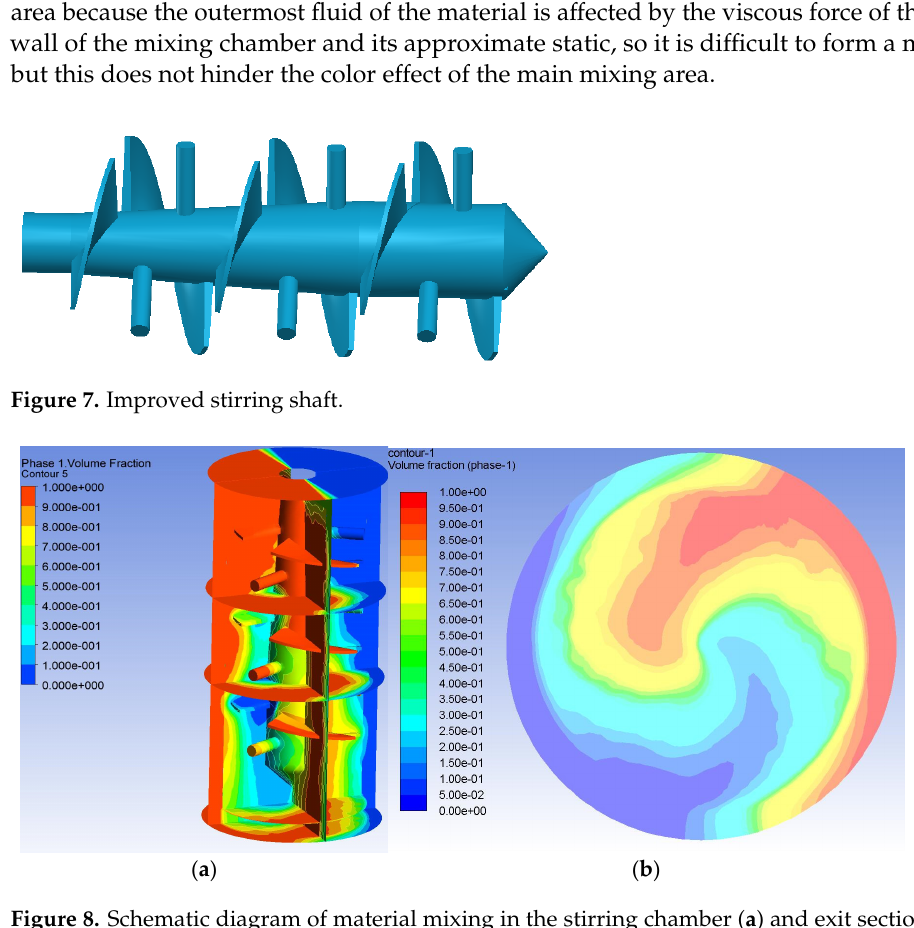
Figure 6. The disconnected spiral blade stirring shaft ( a ), the corresponding simulation ( b ), and the exit section phase distribution ( c ).